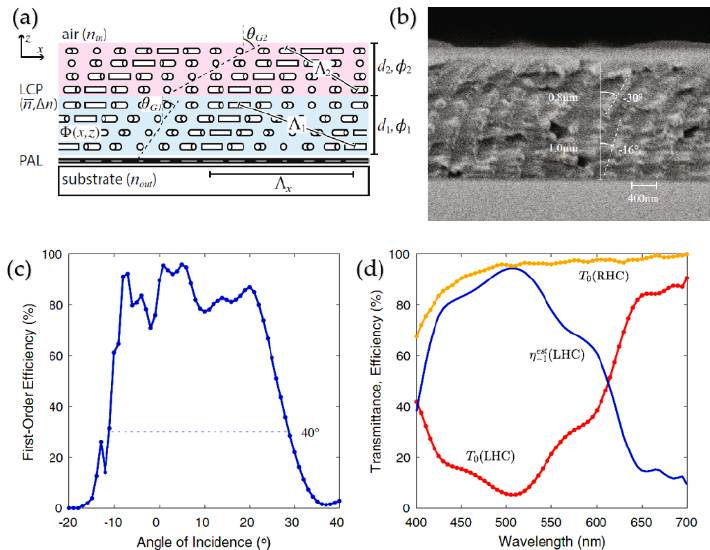
Figure 17. ( a ) Illustration of the director profile of the two-slant LC polymer Bragg PG. ( b ) SEM micrograph of fabricated sample. Measured ( c ) angular response for LCP input polarization at λ = 532 nm, and ( d ) spectral response for circular input polarization at normal incidence [29] .